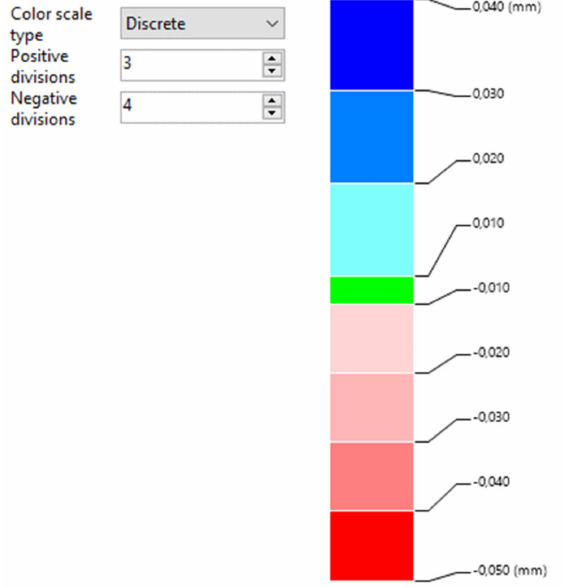
Figure 4. Color scale and deviation values for the scan evaluation software. Table 2. Comparison of simulated and laser scanned surfaces of samples made by 3-axis